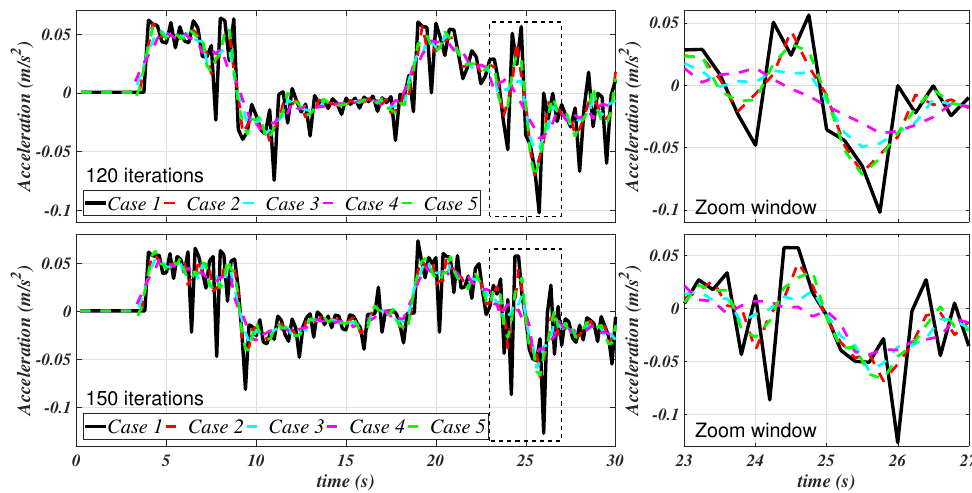
Figure 7. Filtered ˙ u for the filtering cases